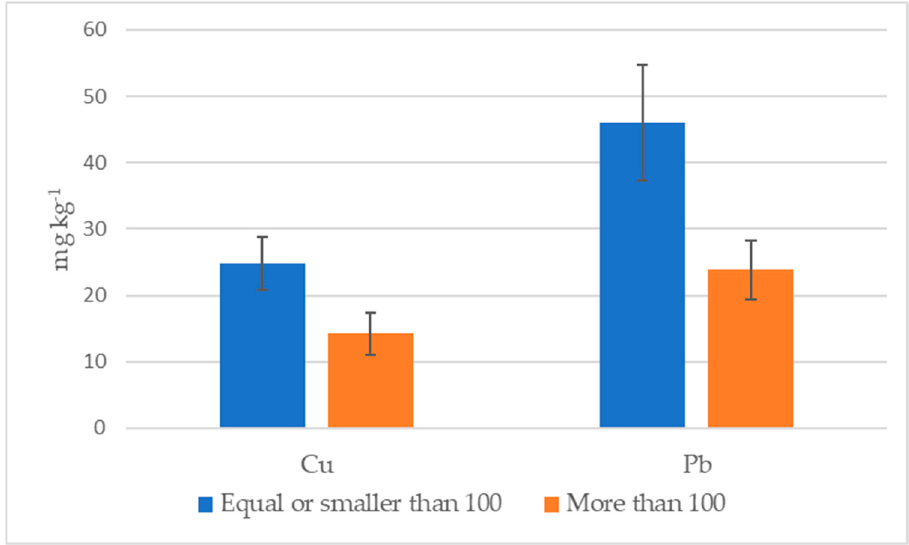
Figure 5. Comparison of Cu and Pb concentration against distance. Relationship distance—land cover (forest).